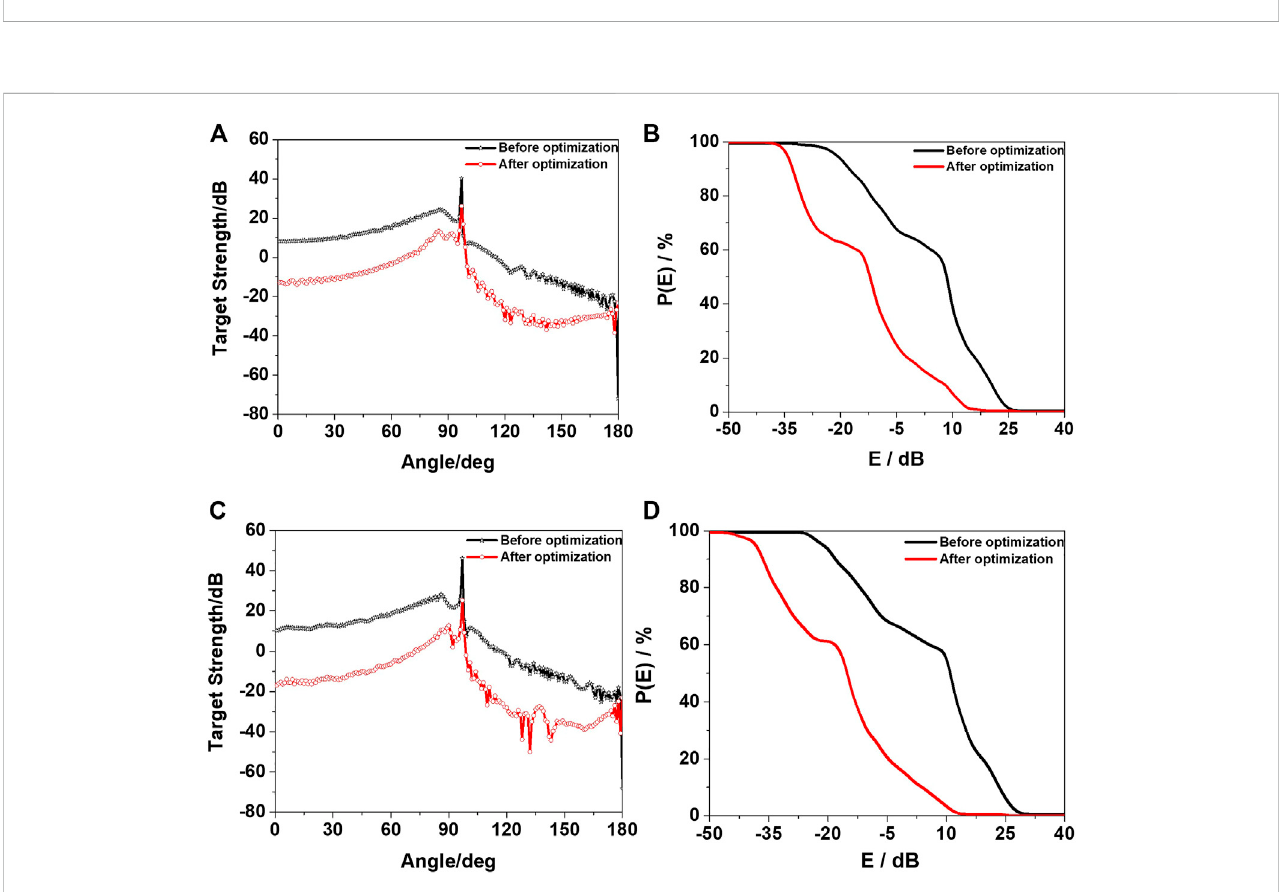
FIGURE 10 Azimuth characteristics and angle detection rate of the conning tower TS before and after optimization. (A,B) are f = 5.0 kHz. (C,D) are f = 10.0